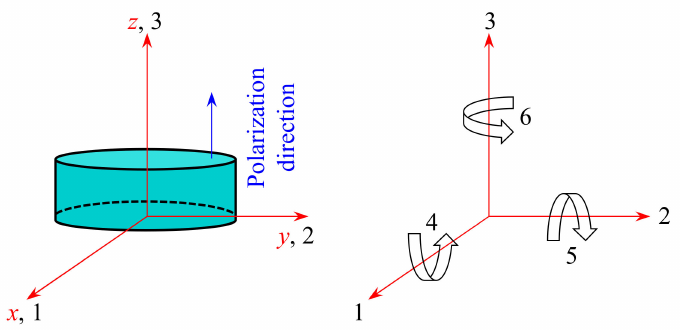
Figure 2. Schematic diagram of crystallographic axes and deformation